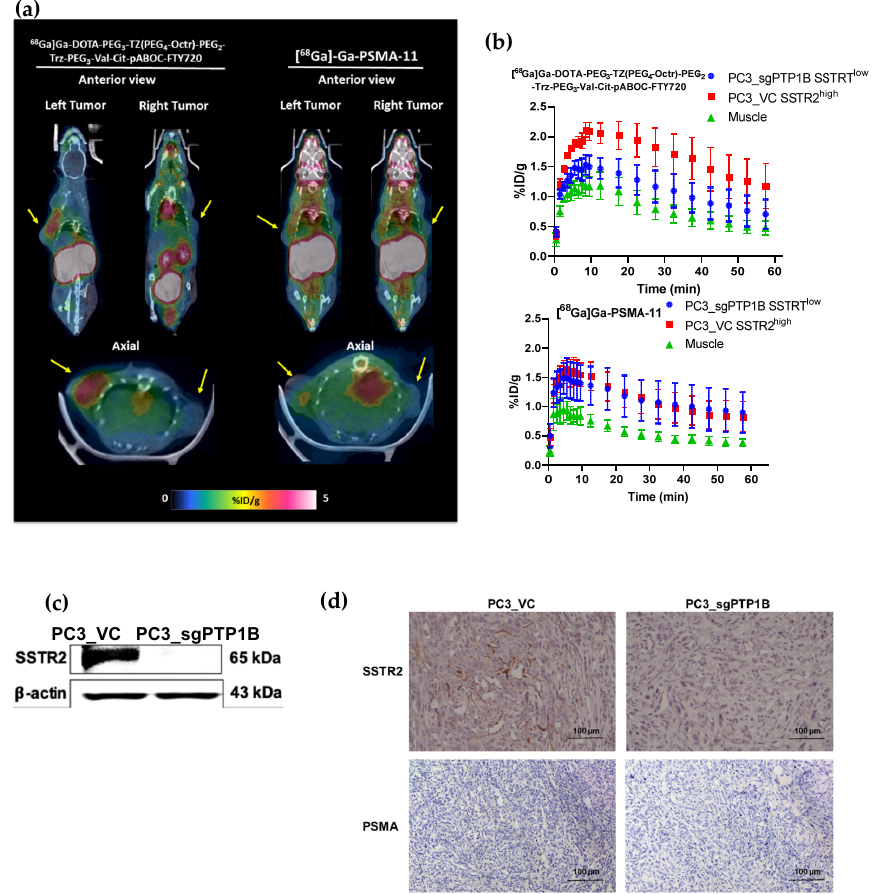
Figure 4. ( a ) Representative PET/CT images of SCID/NOD mice bearing SSTR2 high PC3_VC and SSTR2 low PC3_sgPTP1B xenografts during a 60-min dynamic PET scan with [ 68 Ga]Ga-DOTA-PEG 3 - TZ(PEG 4 -Octr)-PEG 2 -Trz-PEG 3 -Val-Cit-pABOC-FTY720 (left) and [ 68 Ga]Ga-PSMA-11 (right). Yellow arrows indicate the tumors. ( b ) Quantitative PET imaging analysis in tissues of interest. ( c ) Western blot showing high expression of SSTR2 in PC3_VC but low expression in PC3_sgPTP1B ( β -actin as a loading control). ( d ) IHC staining of the excised tumor sections to assess the presence of SSTR2 and PSMA in the tumors. Data are presented as the average %ID/g ± s.d. (n = 4) (unpaired t -tests performed by GraphPad Prism